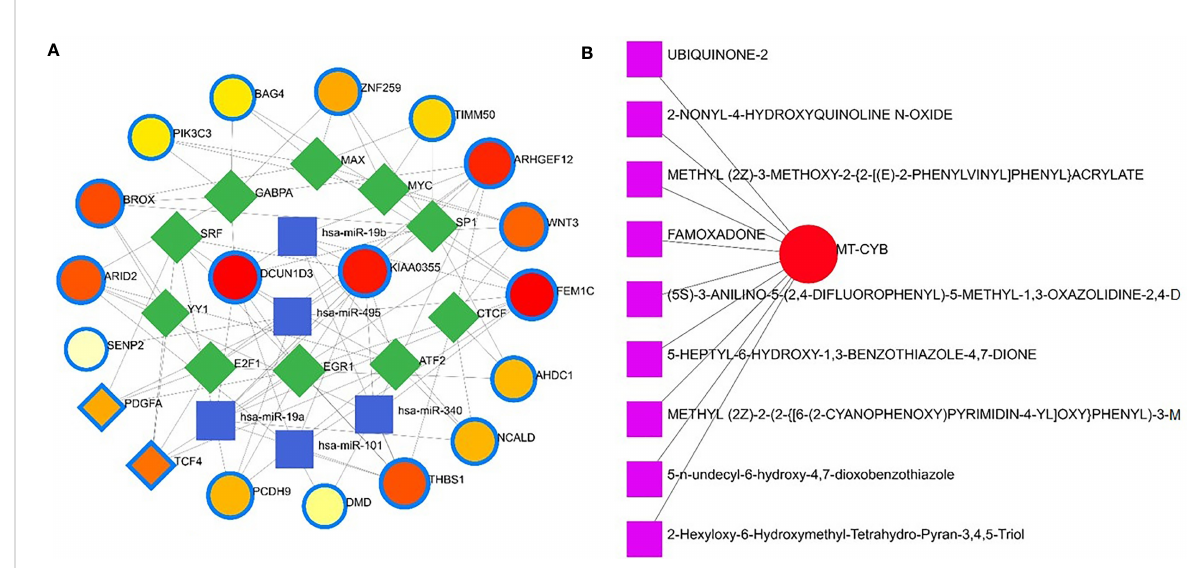
FIGURE 9 Gene regulatory and protein-drug interactions. (A) Gene regulatory networks (TF-miRNA) of the nasopharyngeal epithelial cell in COVID- 19 patients with the shared dysregulated genes. The blue color and square shapes indicate the miRNA, while the green color is square-shapes, representing TF. (B) Protein-drug interaction network. Nine pharmacological compounds are indicated by squares (pink color), while one circle shape (red) represents the hub